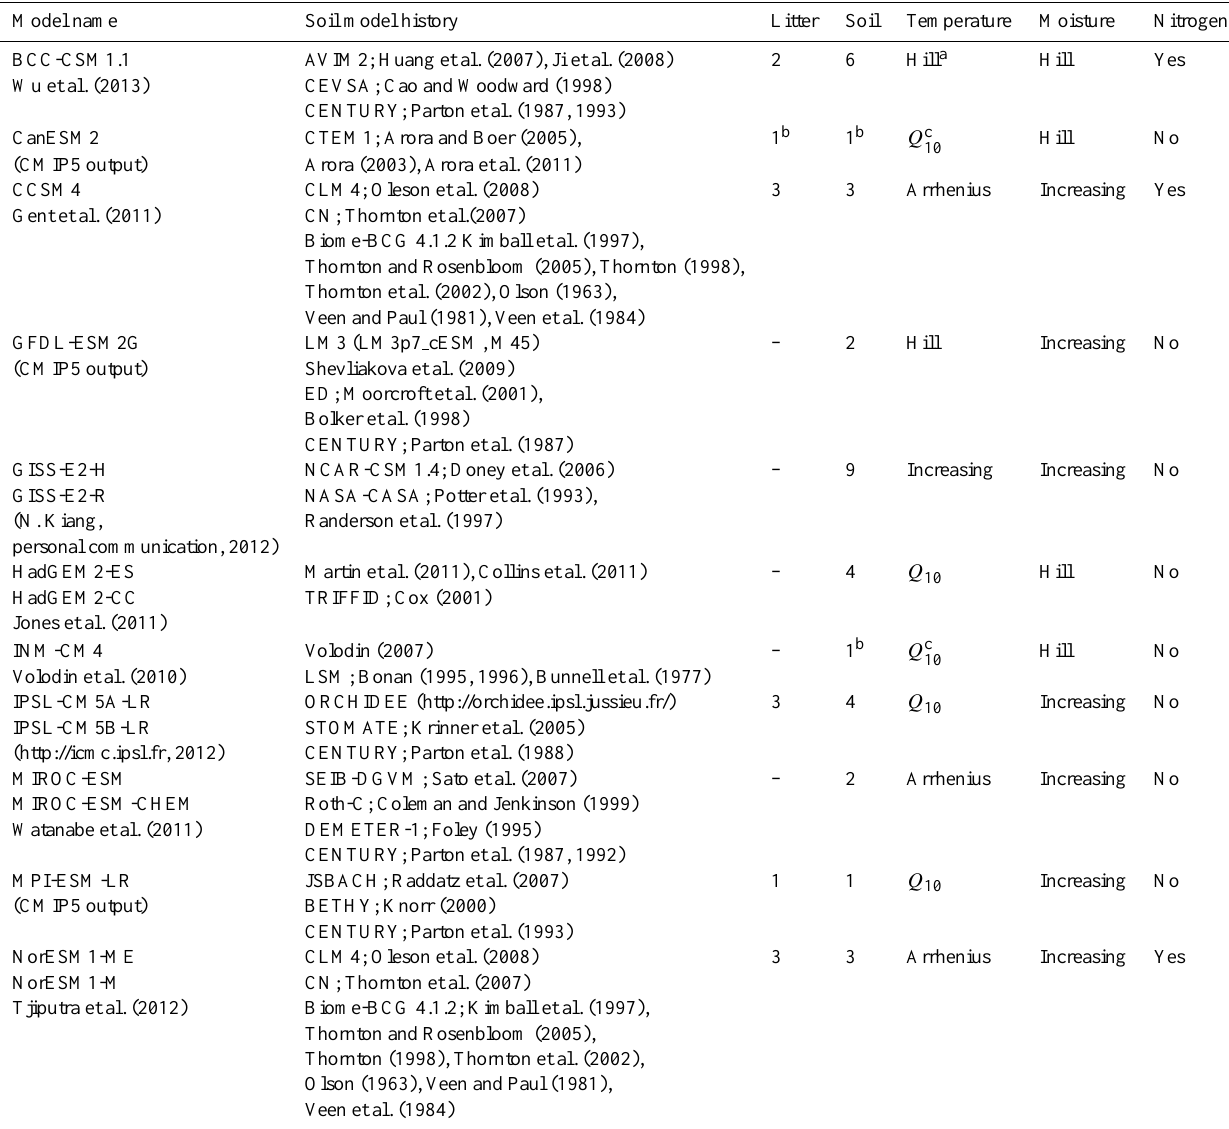
Table 1. Summary of soil carbon models including Earth system model names, history of model development, number of litter and soil pools, temperature and moisture functions, and representation of nitrogen